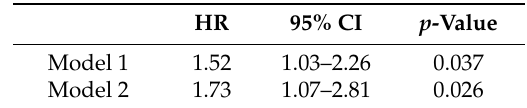
Model 1: adjusted for age, sex, hypertension, smoking status, diabetes, hyperlipidemia, BMI; Model 2: Model 1 additionally adjusted for hemoglobin, log (NT-proBNP), log (troponin I). HR = hazard ratio, CI = confidence interval.